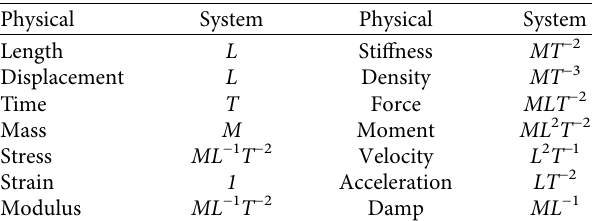
Figure 5: Diagram of a spherical bearing under vertical load and rotation. Table 1: Physical dimension of